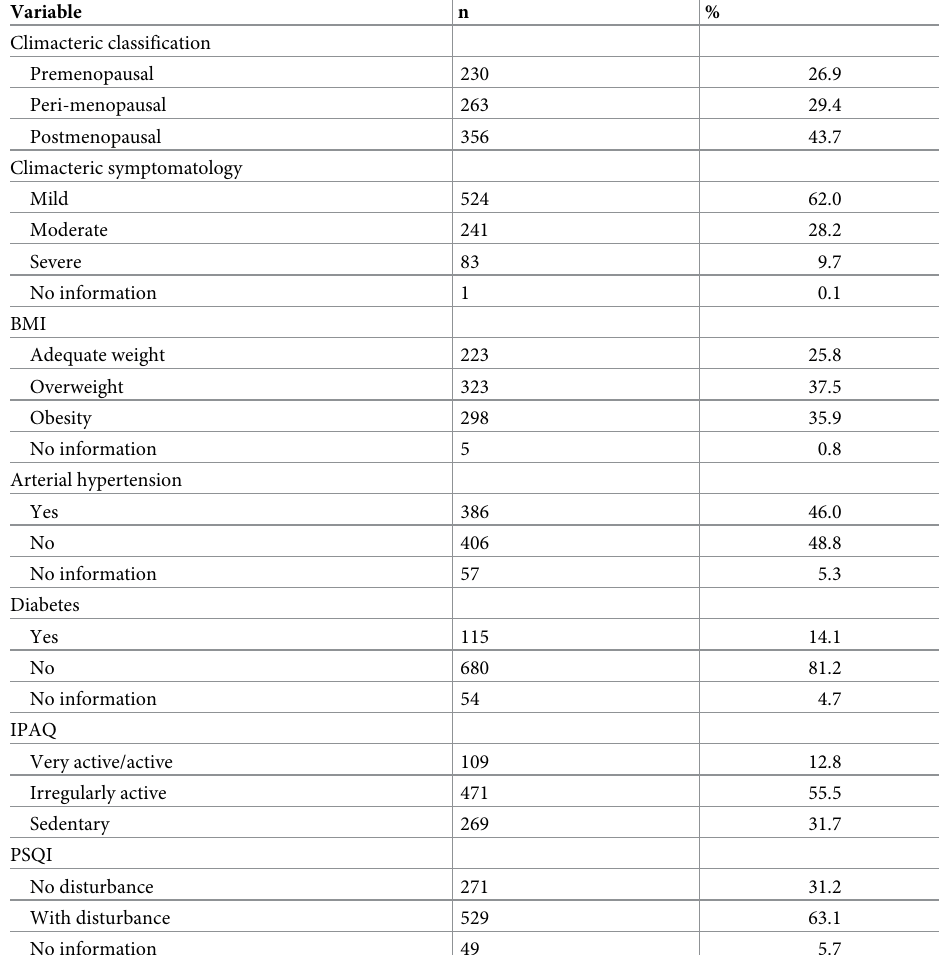
Table 2. Characteristics related to life habits and health care of climacteric women assisted by primary health care,